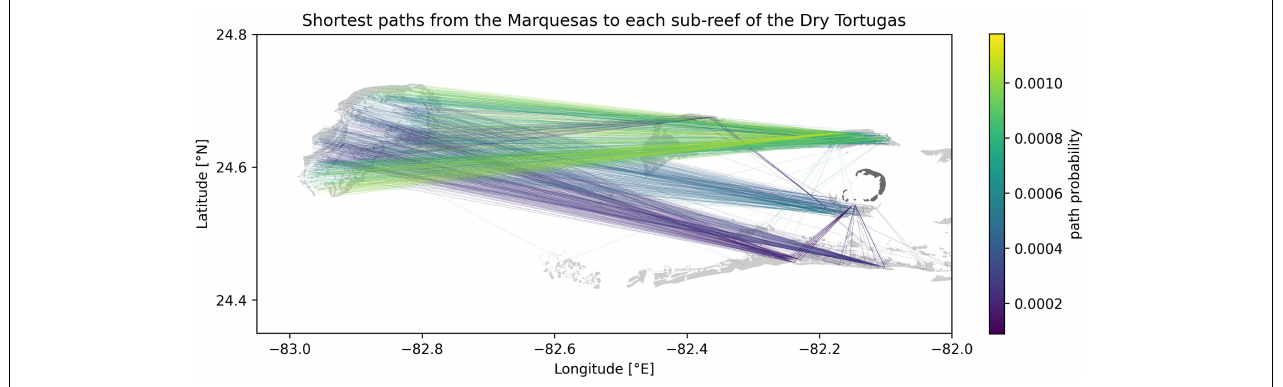
FIGURE A1 | Shortest paths to each sub-reef of the Dry Tortugas from the Marquesas computed from the yearly averaged connectivity matrix obtained with mean barotropic currents. Reefs are highlighted in light gray while islands are shown in dark